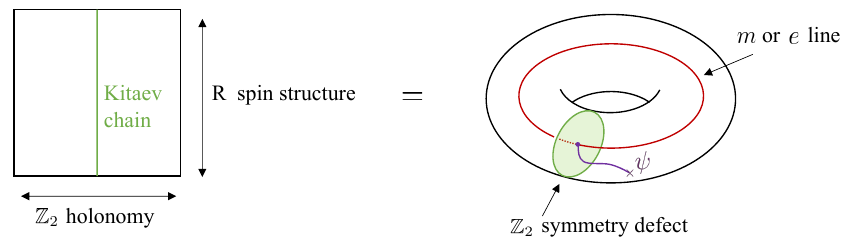
Figure 26: A state of the fermionic SPT phase on a torus is described by a path integral of the bosonic shadow theory on the solid torus D 2 × S 1 . When we have R spin structure along the meridian and the (cid:90) holonomy along the longitude, the state 2 must carry odd fermion parity, so a ψ line must be running along the time direction. This constrains the action of (cid:90) symmetry defect on anyons in the bosonic shadow 2